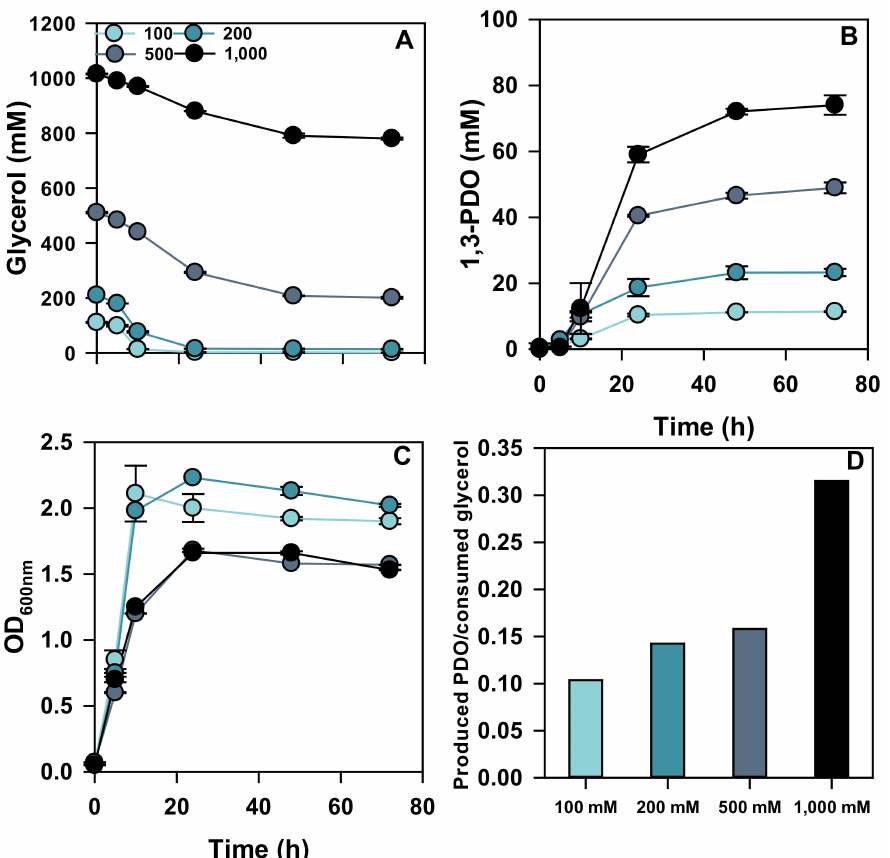
Figure 2. Production difference due to pure glycerol concentration 100, 200, 500, and 1000 mM. ( A ) Glycerol consumption, ( B ) 1,3-PDO production, ( C ) optical density (600 nm), and ( D ) 1,3-PDO production yield (mol/mol). Table 2. Production difference due to pure and crude glycerol concentration 100, 200, 500, and 1000 mM. Initial Type of Glycerol